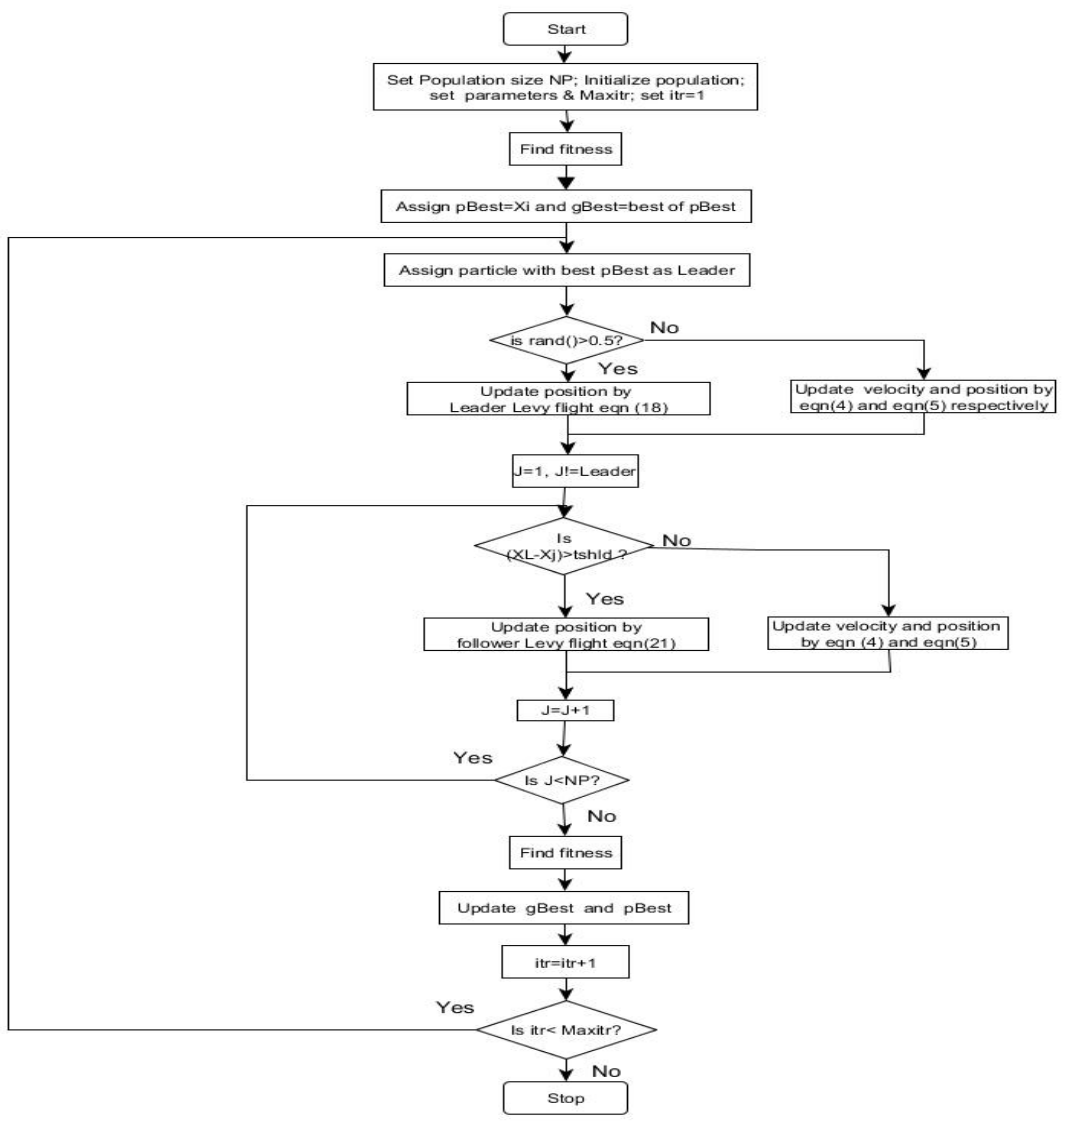
Figure A1. Flowchart of LIPSO